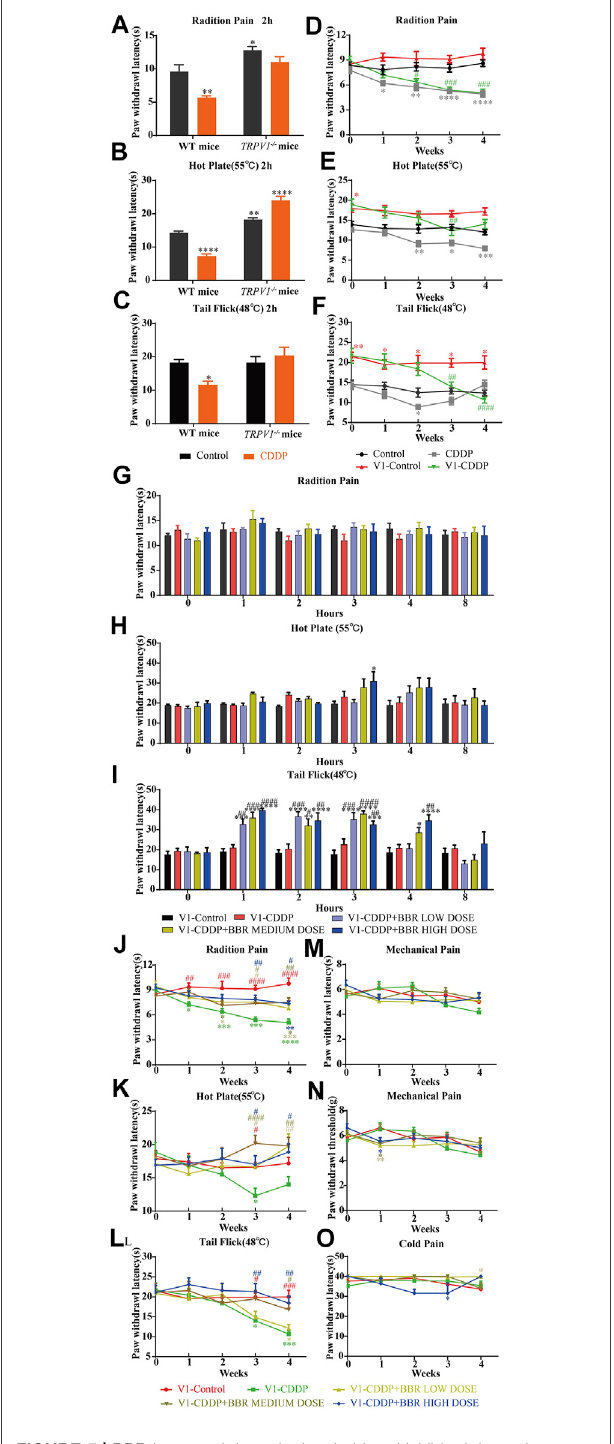
FIGURE 5 | BBR increased the pain threshold and inhibited thermal hyperalgesiainducedbyCDDPin TRPV1 − / − mice. (A – C) Heatpainthresholds in TRPV1 − / − mice increased 2 h and 4 weeks after initial administration.